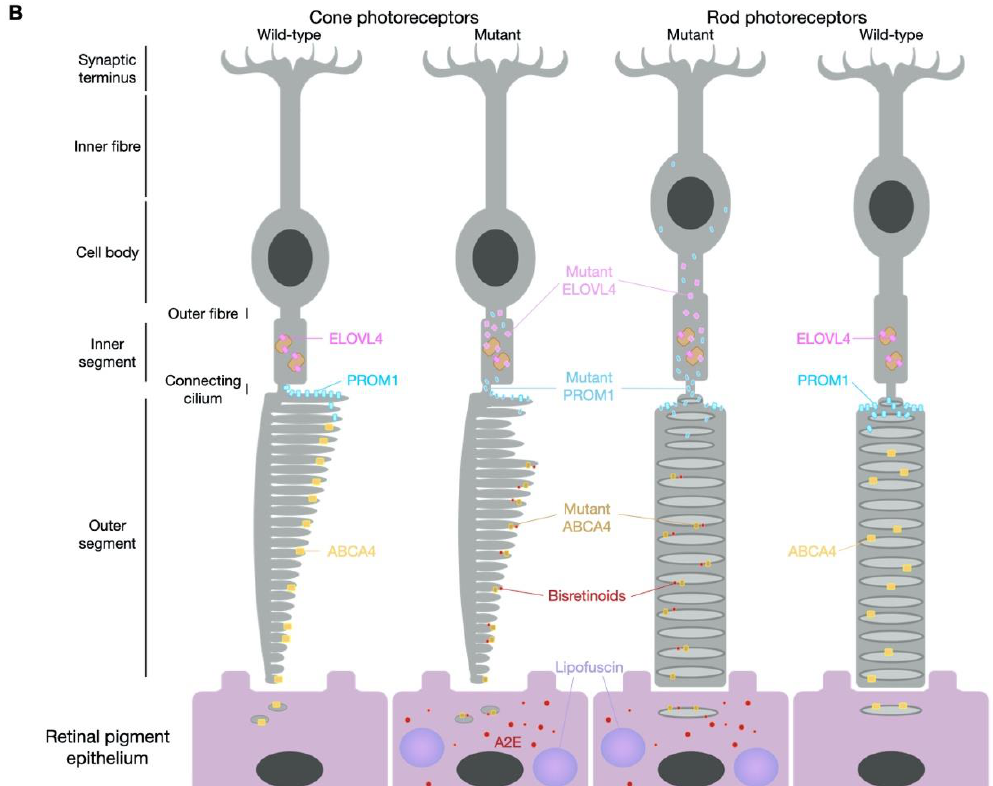
Figure 1. Comparisons of the human and mouse cone photoreceptor distribution and localisations of ABCA4, ELOVL4 and PROM1. ( A ) Rod photoreceptors comprise the majority of light-sensitive cells of the mouse retina with cone photoreceptors occurring in a decreasing gradient of medium-wavelength, medium/short-wavelength and short-wavelength sensitive varieties in a dorsal to ventral direction. By comparison, the human retina contains a macula region in which the foveola provides the site of maximum visual acuity and is densely packed with long- and medium-wavelength sensitive cone photoreceptors with short-wavelength sensitive cone photoreceptors occurring sporadically amongst the cones in the fovea centralis of the macula. Stargardt disease is characterised by a loss of cells in the cone-rich macula region. ( B ) In a wild-type state, ELOVL4 is located in the endoplasmic reticulum of photoreceptor cells, with mutant forms becoming mislocalised as well as losing function. PROM1 is typically located at the base of the outer segments where new discs are formed, and mutant PROM1 mislocalises within the photoreceptor cells and disc morphogenesis occurs. ABCA4 is present on the disc membranes and in mutant form causes dysregulation of the visual cycle, causing build-up of unwanted compounds in the disc membranes. When consumed by the RPE, these toxic compounds lead to lipofuscin accumulation and ultimately death of the RPE. ABCA4 = ATP-binding cassette transporter protein 4; ELOVL4 = elongation of very-long-chain fatty acids; PROM1 = prominin 1; RPE = retinal pigment epithelium.